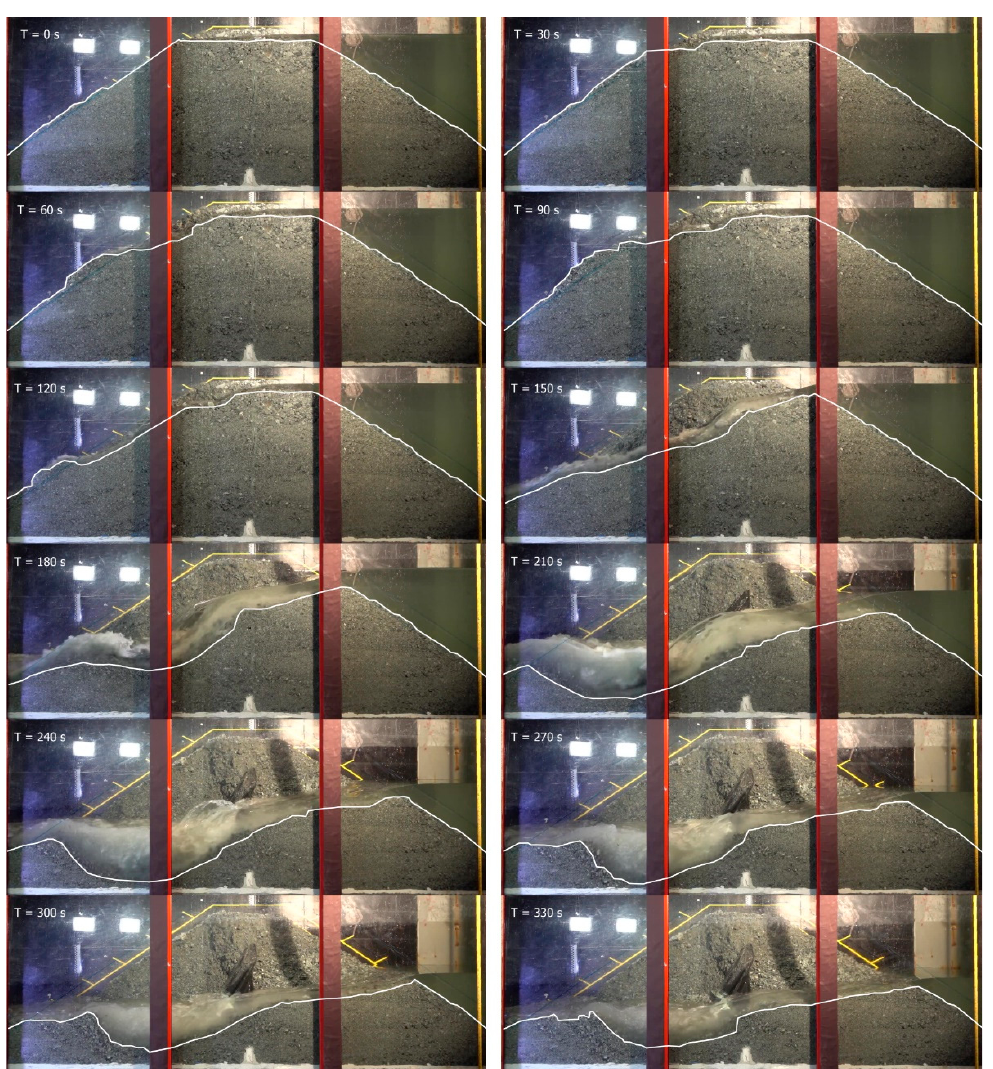
Figure 8. Side-view tracking of breach progression of model U4 (central core); direction of flow is right to left; white line indicates traced solid surface.